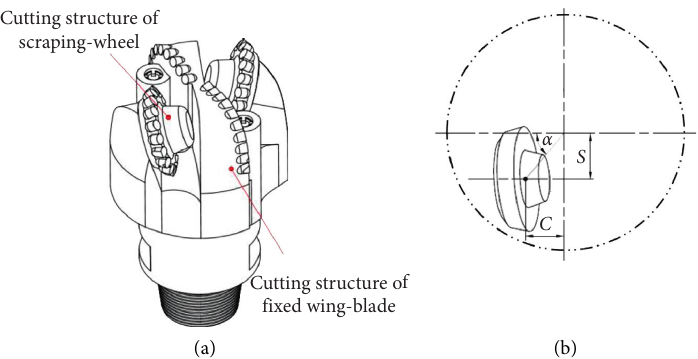
Figure 1: Structure and bottom-hole pattern of the cross-cutting PDC bit. (a) Cross-cutting PDC bit, (b) Angular deflection of the scraping- wheel.